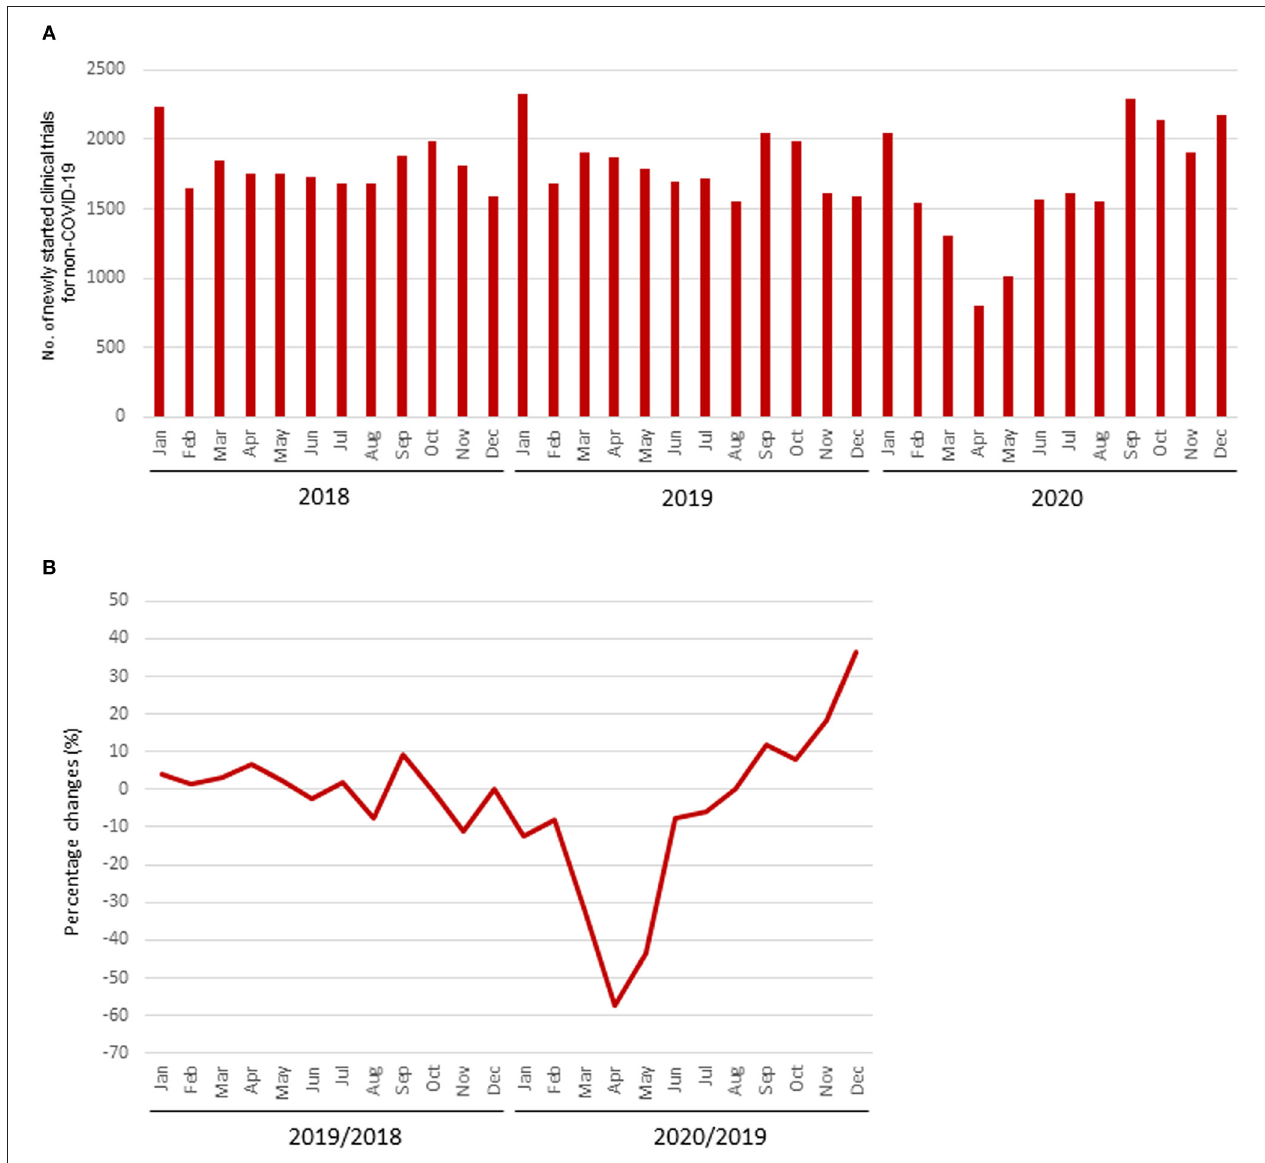
FIGURE 1 | Number of newly started clinical trials. (A) Number of newly started clinical trials for diseases other than COVID-19; (B) Percentage change of newly started clinical trials for diseases other than